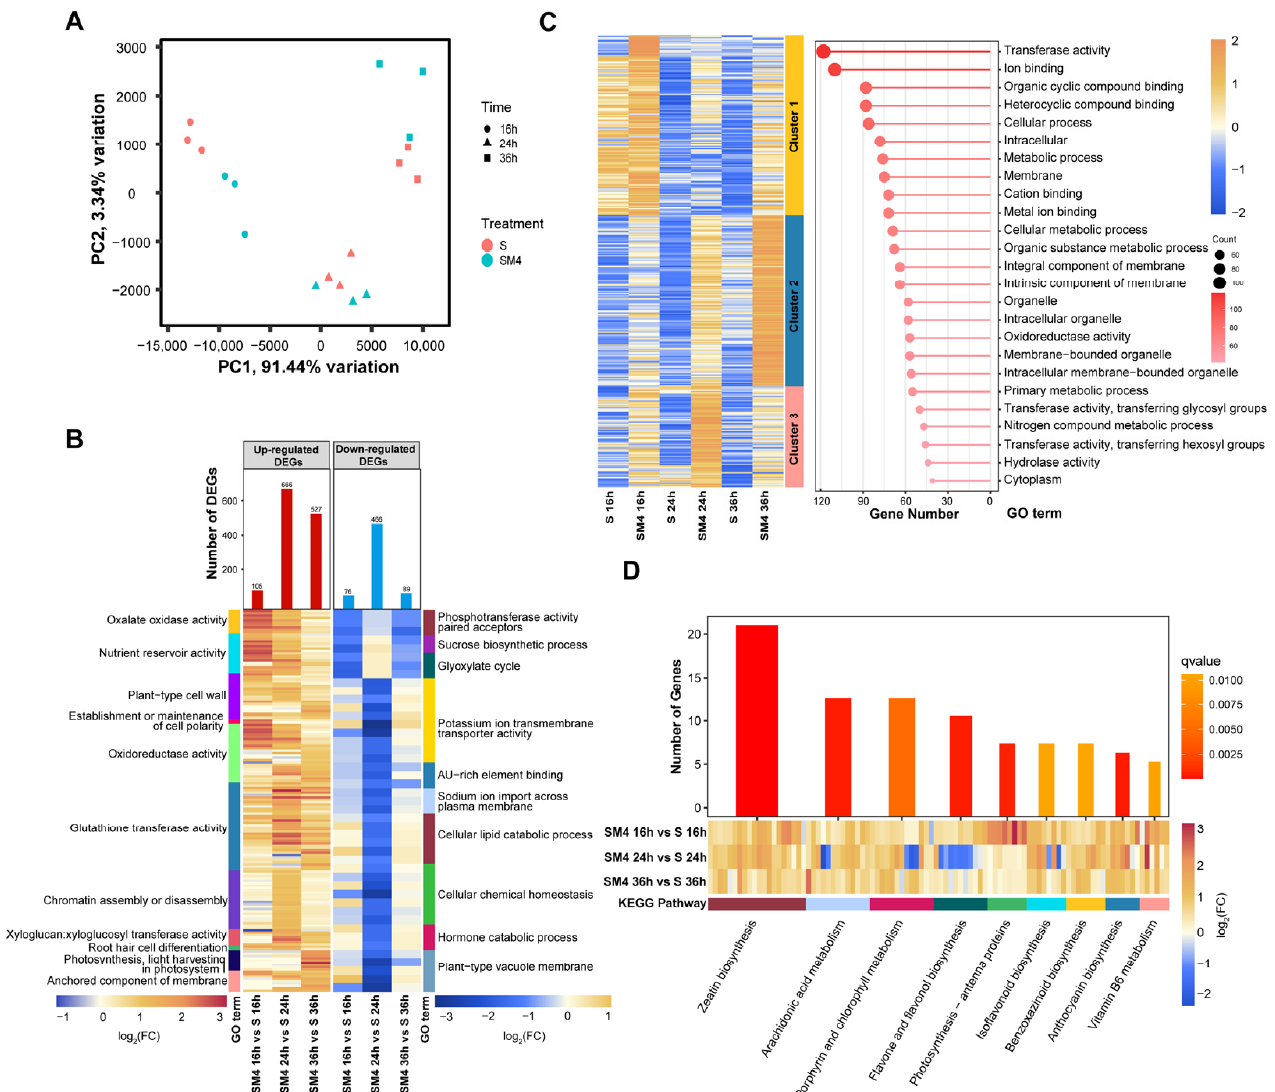
Figure 3. Overview of the transcriptomic changes during three different time samples of S and SM4. ( A ) Principal component analysis (PCA) of all samples. ( B ) Gene Ontology (GO) enrichment analy- sis of deferentially expressed genes (DEGs) in three-time points. The total number of up-regulated DEGs (red) or down-regulated DEGs (blue) in each comparison was shown above each bar. Heatmap of DEGs in the GO terms (q-value < 0.05) that were affected by MT. ( C ) The heatmap of three clusters in which the genes were up-regulated in SM4 condition, and the GO annotation of the DEGs in these three clusters. ( D ) Kyoto Encyclopedia of Genes and Genomes (KEGG) pathway anal- ysis of all DEGs. The color of the bar chart showed the significance levels (q-value), and the color scale of the heat map represents up-regulated (red) and down-regulated (blue).